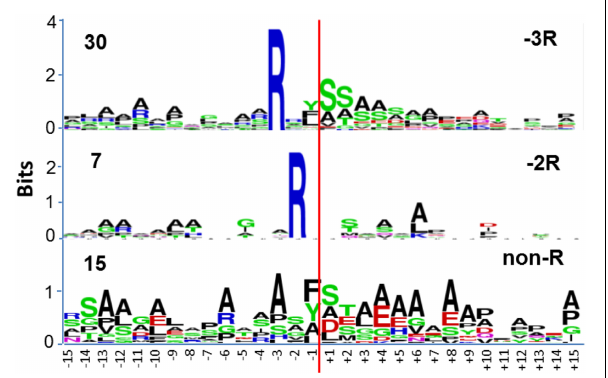
FIGURE 2 | Sequence logo analysis of 52 rice mitochondria protein precursors at the region of the cleavage site. The red line indicates the cleavage sites as supported by proteomic evidence.The cleavage sites are grouped into three classes (class II, -3 Arg; Class I -2 Arg; non-conserved Arg, class III).The numbers on the left side represent the total sequences identified in different groups for sequence logo analysis. Data adapted from Huang etal.